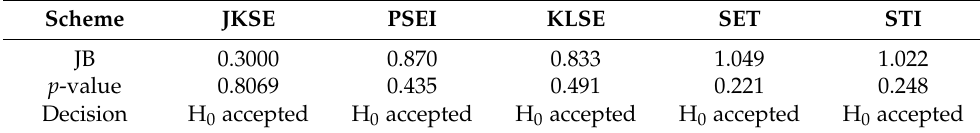
Table 4. Jarque–Beranormality test result for ASEAN top 5 stock price index returns.